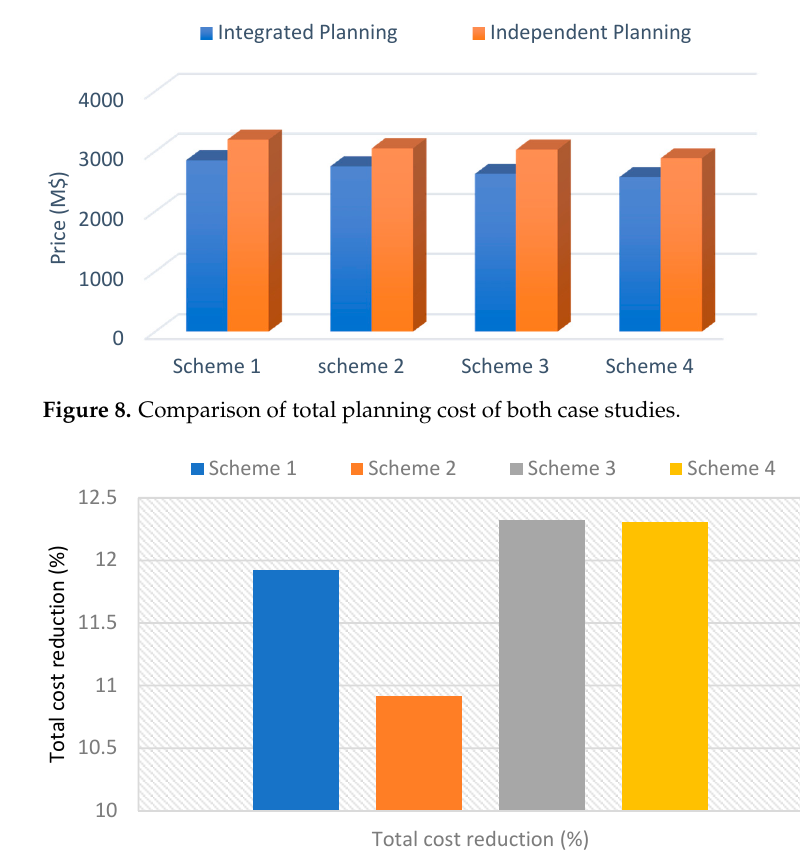
Figure 9. Total cost reduction in four different schemes.